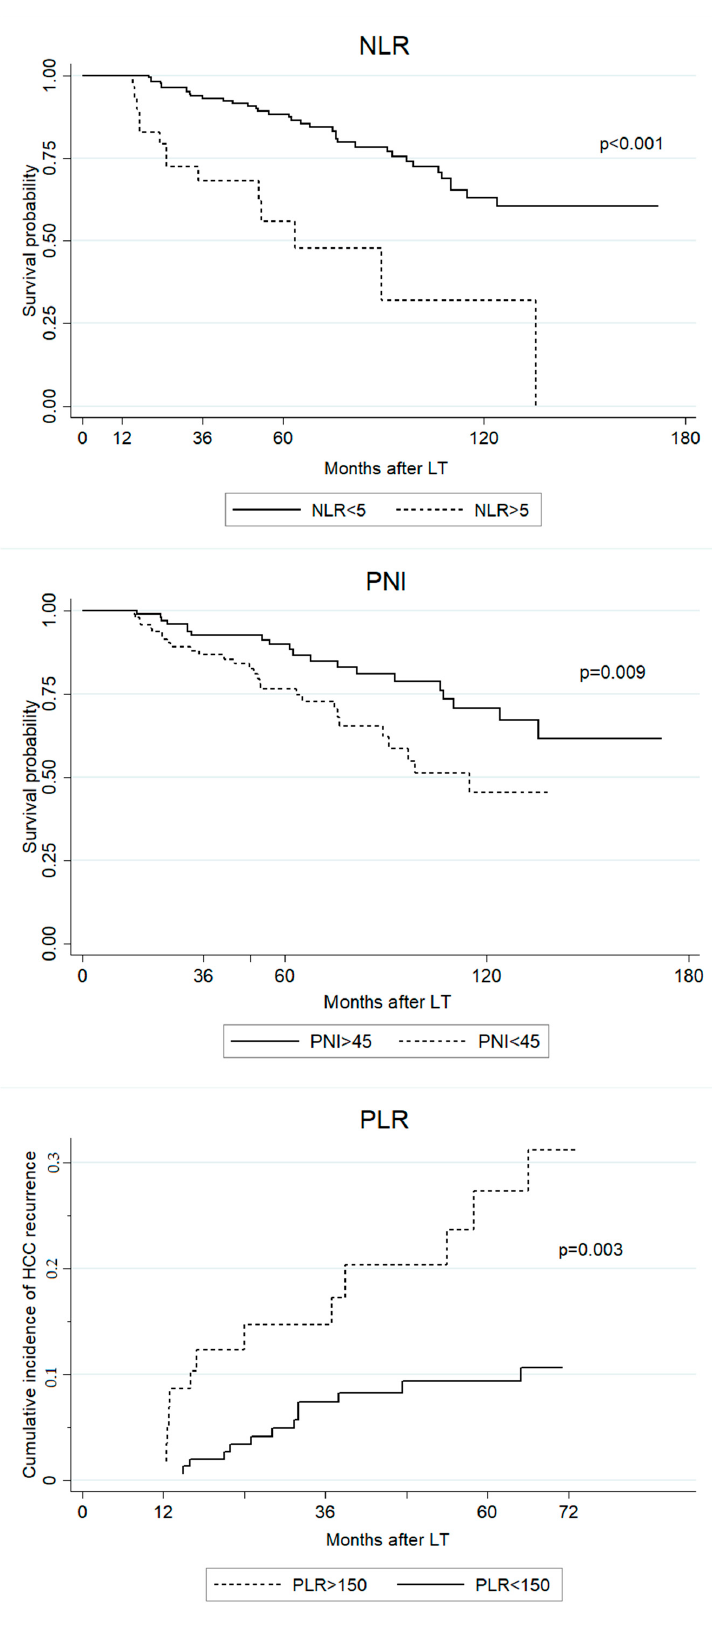
Figure 2. Predictive value of NLR, PNI, and PLR for long-term outcomes, using conventional clinically-oriented cutoffs